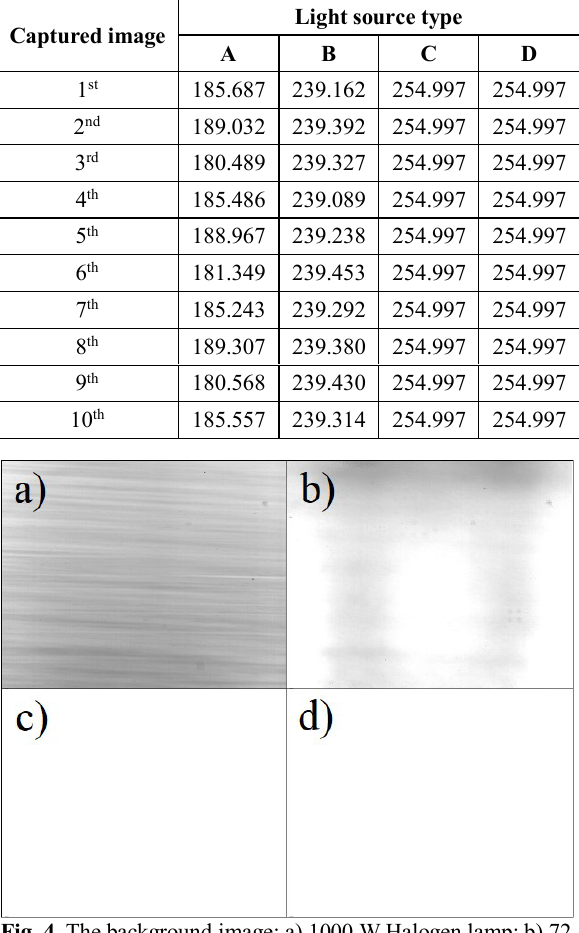
Fig. 4. The background image: a) 1000 W Halogen lamp; b) 72 W LED bar panel; c) 60 W LED chip; d) 90 W LED chip. LED chip) ensure practically white image